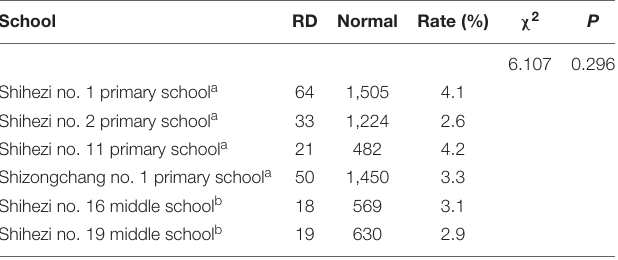
TABLE 2 | The prevalence rate of reading disabilities (RDs) in different schools.